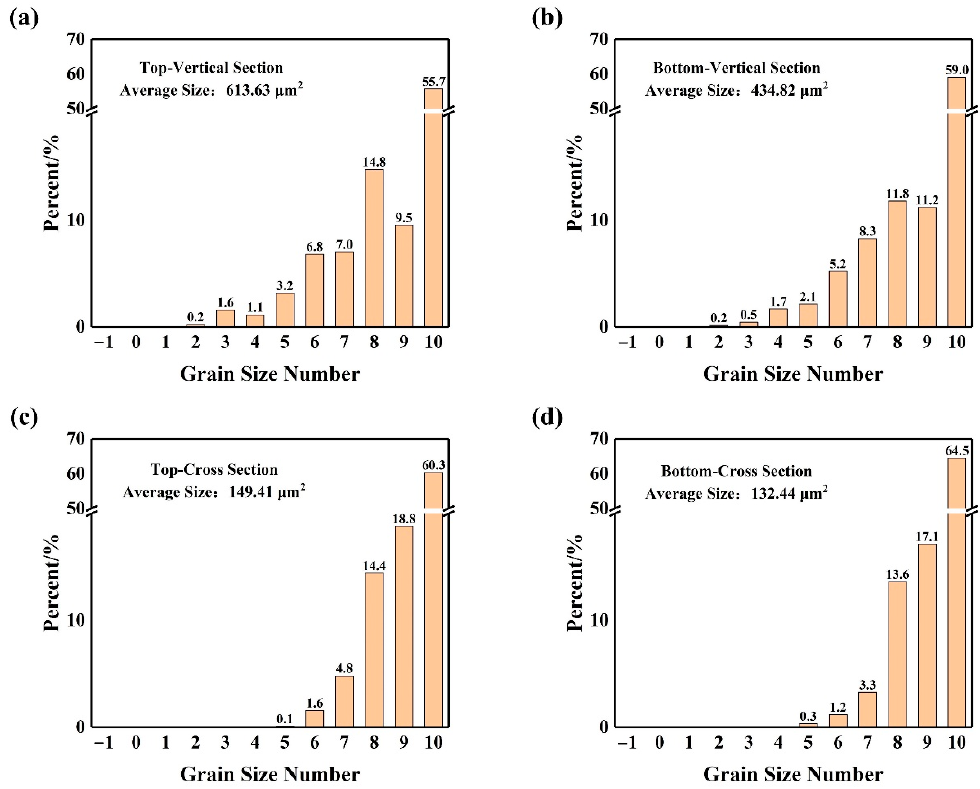
Figure 11. Grain size distribution of vertical sections ( a , b ) and cross-sections ( c , d ) of FeCrAl cladding at the top region ( a , c ) and the bottom region ( b , d ).